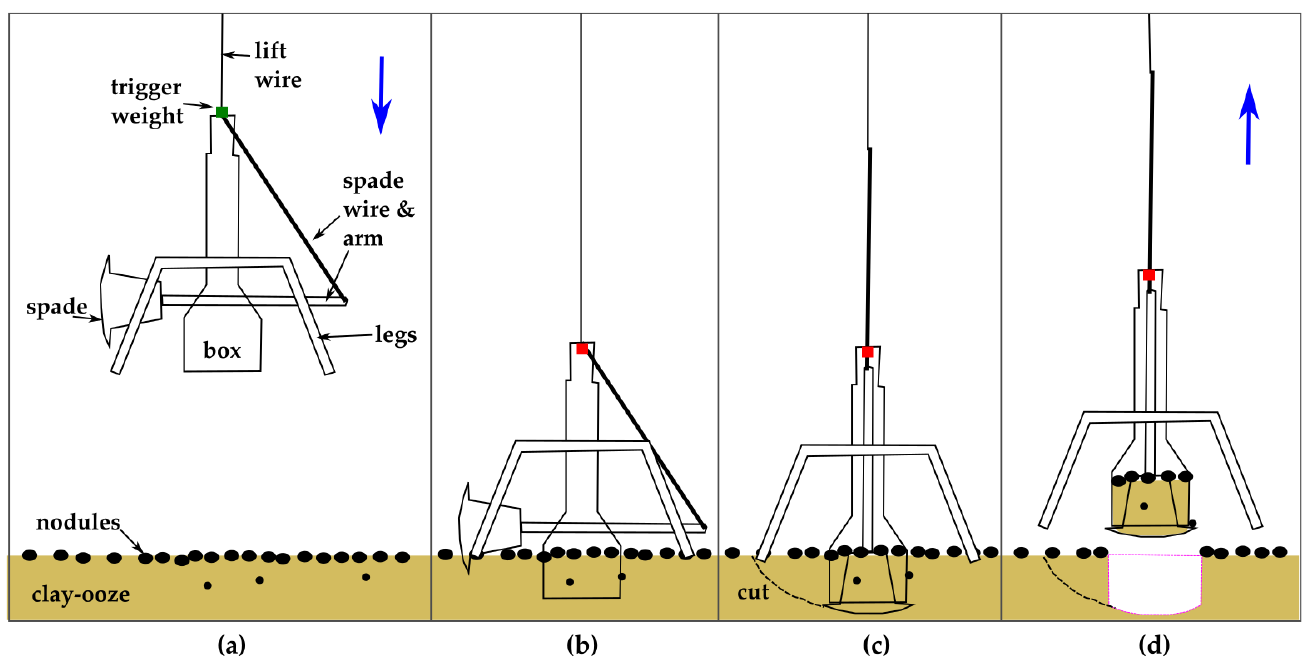
Figure 15. Schematic of the sampling process of nodules using a box corer (BC). ( a ) Descent on wire; ( b ) landing and trigger; ( c ) spade pulled to base of box by the lift and spade wire at the start of ascent; ( d ) lifted ascent. Modified from Lee et al. [60].